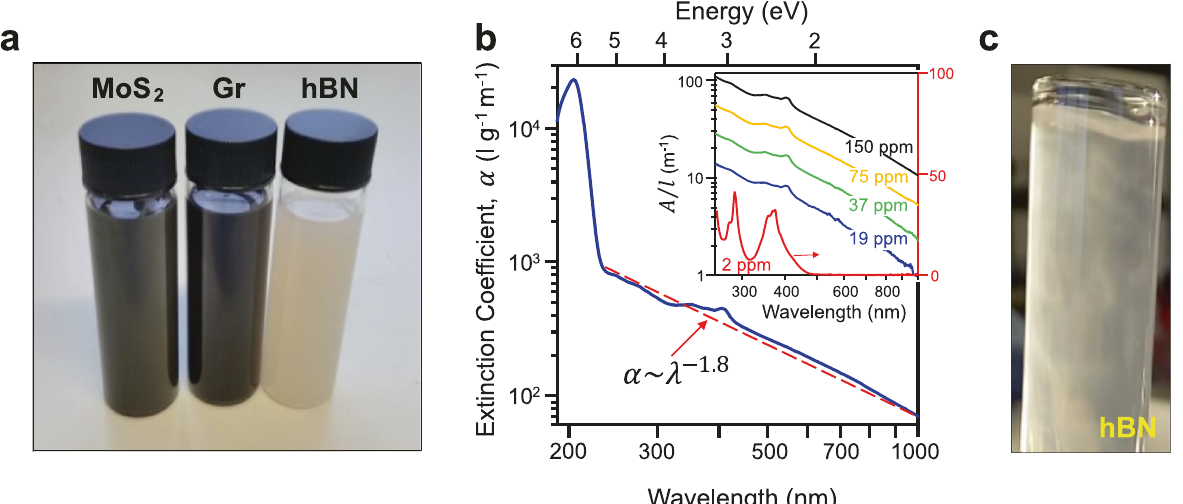
Fig. 1 Superacid assisted exfoliation of the large-area solution-processable 2D materials. a Photograph of exfoliated of MoS 2 , graphene, and hBN nanosheets dispersed in N-methyl-2-pyrrolidone (NMP) at a concentration of around 0.5 g l − 1 . b The Ultraviolet – Visible (UV – Vis) absorption spectra of the aqueous dispersions of exfoliated hBN 2D sheets represented as the extinction coef fi cient α versus the wavelength λ (blue curve). The spectrum demonstrates the absorption onset at around 6 eV, corresponding to the hBN bandgap. The red dashed line is the power-law approximation of the extinction coef fi cient. The feature in the spectrum between 300 and 500 nm is associated with absorption by the pyrene sulfonate functionalisation molecules. Inset: The spectra of the absorption coef fi cient A per length l , of the same hBN dispersion taken at different nanosheet concentrations (blue, green, orange and black curves). The red curve is the reference absorption spectrum of the pyrene sulfonate dispersed in the water showing typical absorbance in the UV region. c Photograph of hBN nanosheet dispersion in NMP (0.1 g l − 1 ) illustrating the shear-induced birefringence visible as a colour